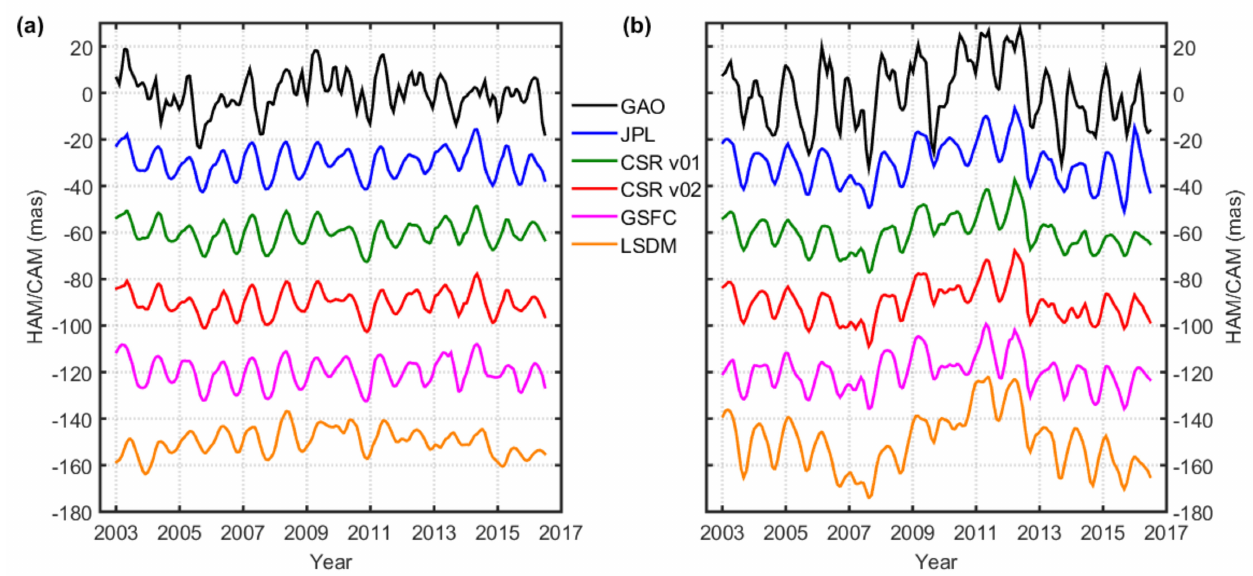
Figure 1. Comparison of detrended time series of the ( a ) χ 1 and ( b ) χ 2 components of GAO, GRACE-based HAM/CAM, and LSDM-based HAM. For better visibility, time series have been shifted relative to each other by adding a